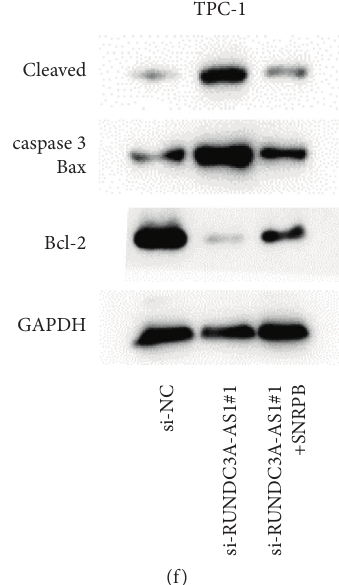
Figure 5: Overexpression of SNRPB reverses the effects of RUNDC3A-AS1 knockdown on cell proliferation and apoptosis. (a) RT-qPCR showed that SNRPB overexpression reversed the expression level of SNRPB caused by RUNDC3A-AS1 knockdown. (b) Cell viability was examined by the CCK-8 assay. (c, d) The EdU assay was conducted to detect cell proliferation. (e) Flow cytometry was used to test cell apoptosis. (f) The Western blot was employed to examine the protein level of apoptosis-related factors. ∗ P < 0 . 05; ∗∗∗ P < 0 .